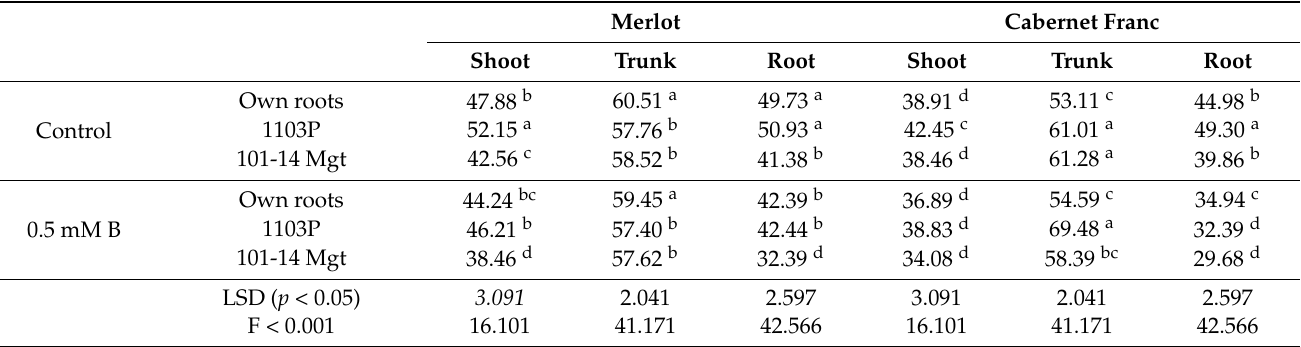
Table 3. The effect of boron toxicity on root, trunk, and shoot dry weight (g), of own-rooted or grafted onto 1103P and 101-14 Mgt rootstocks of Merlot and Cabernet Franc vine cultivars. Merlot Cabernet Franc Shoot Trunk Root Shoot Trunk